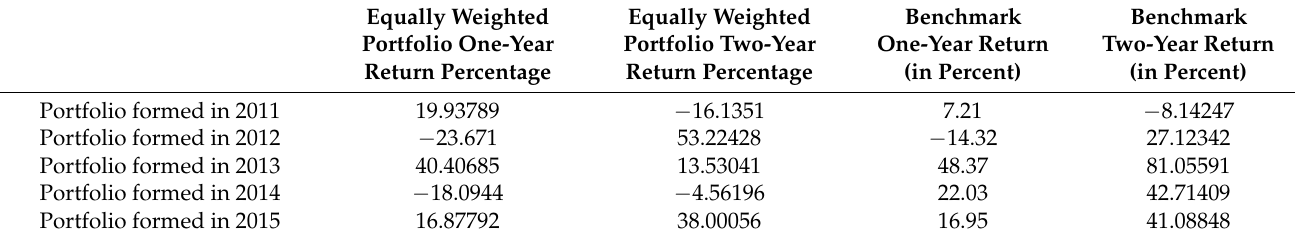
Table 6. Cumulative returns from the portfolios in Tables